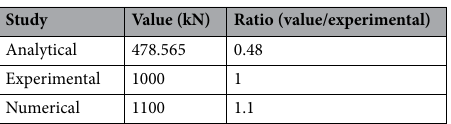
Table 4. Comparison of the analytical/experimental/numerical analysis.